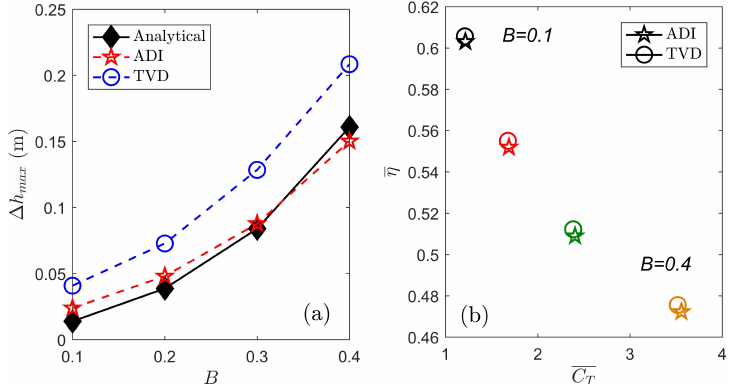
Figure 9. Effect of the blockage ratio on the maximum head drop ( a ) and the turbine’s efficiencies ( b ); results obtained for a fence configuration. Reproduced from [55] with permission from